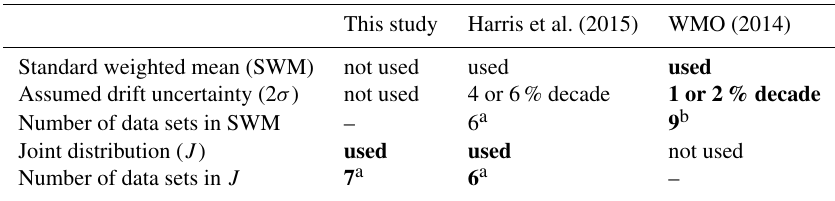
Table 5. Approaches taken to obtain the average trend and its uncertainty estimate in the present study, in Harris et al. (2015) and in WMO (2014). Boldface indicates the approach used for the results plotted in Fig. 5. This study Harris et al. (2015) WMO (2014) Standard weighted mean (SWM) not used used used Assumed drift uncertainty (2 σ ) not used 4 or 6% decade 1 or 2% decade Number of data sets in SWM – 6 a 9 b Joint distribution ( J ) used used not used Number of data sets in J 7 a 6 a